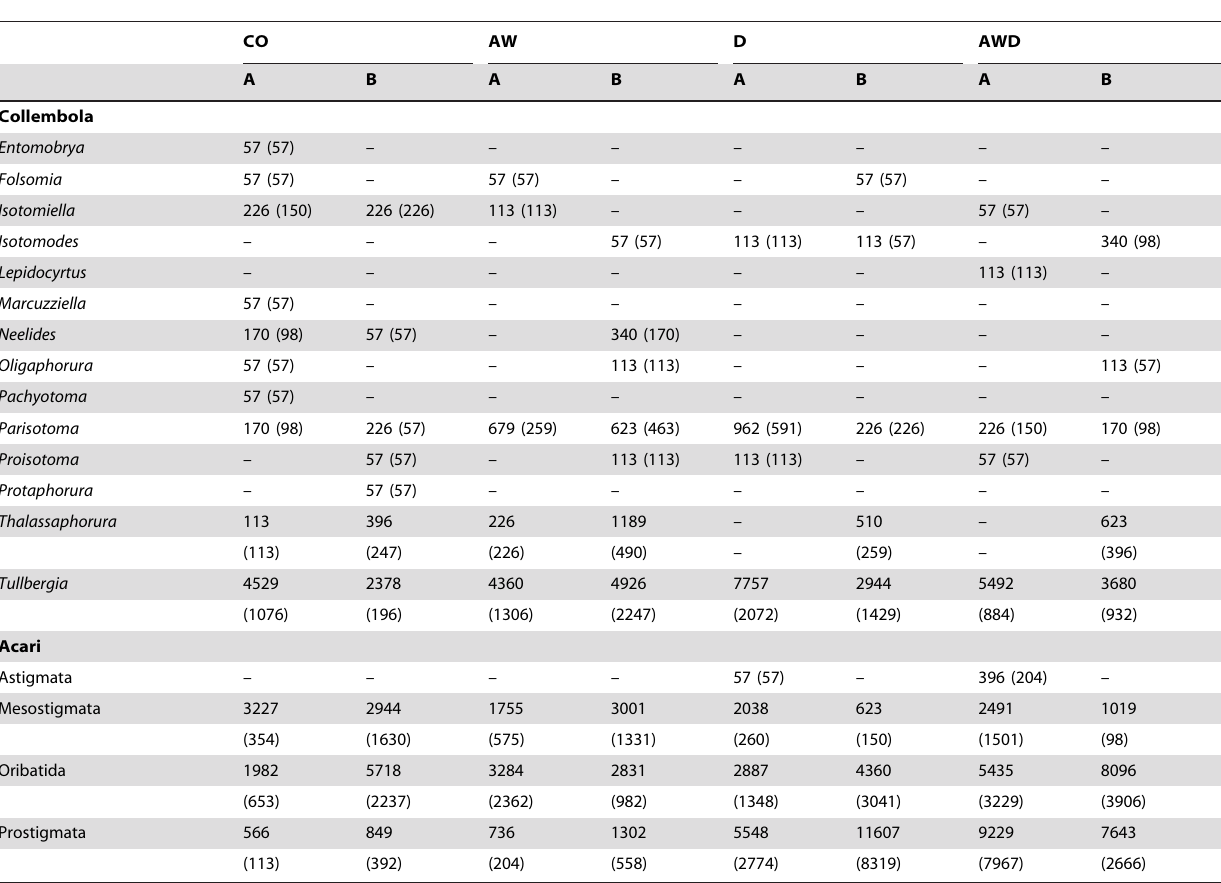
Table 2. Abundance of soil Collembola and mites sampled in the Querco experiment.